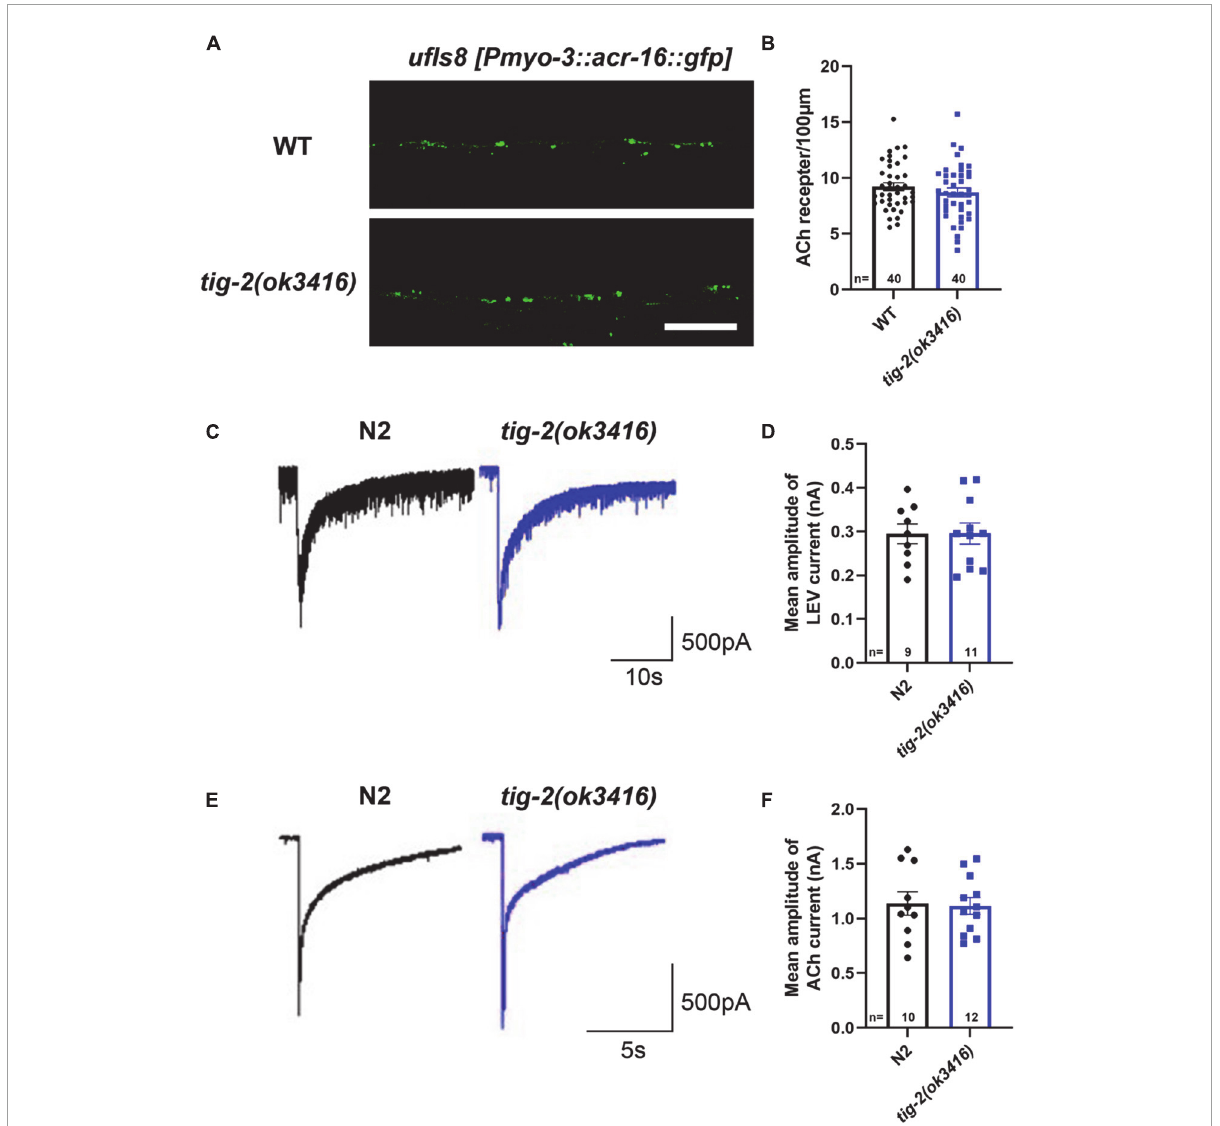
FIGURE3 tig-2 mutants and wild-type worms display similar density and function of postsynaptic AChRs. (A) Images of the post-synapse on the dorsal nerve cord. Scale bar is 10 µ m. (B) Quantification of the density of post-synapses. The density of postsynaptic AChRs is unchanged in tig-2 ( ok3416 ) mutant ( p = 0.3327). (C,E) Postsynaptic currents at NMJs evoked by levamisole (C) or ACh (E) . (D,F) Levamisole-evoked current ( p = 0.9811) and ACh-evoked current ( p = 0.8671) are similar in tig-2 ( ok3416 ) mutants and wild-type worms. A Student’s t -test was performed for each statistical analysis. Error bars represent